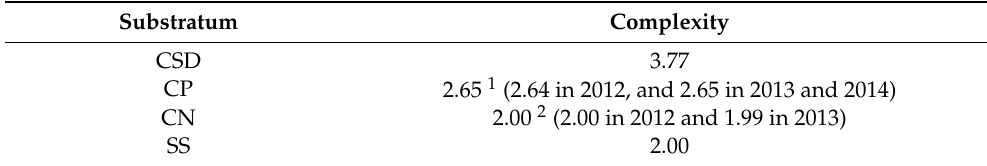
Table 3. Structural complexity of the